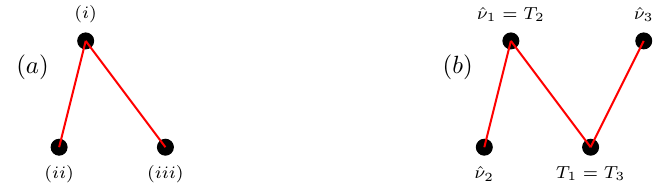
Figure 8.1: (a) Graph representation of E m as defined in [DDNY18]. (b) Graph represen- tation of E m as defined in this